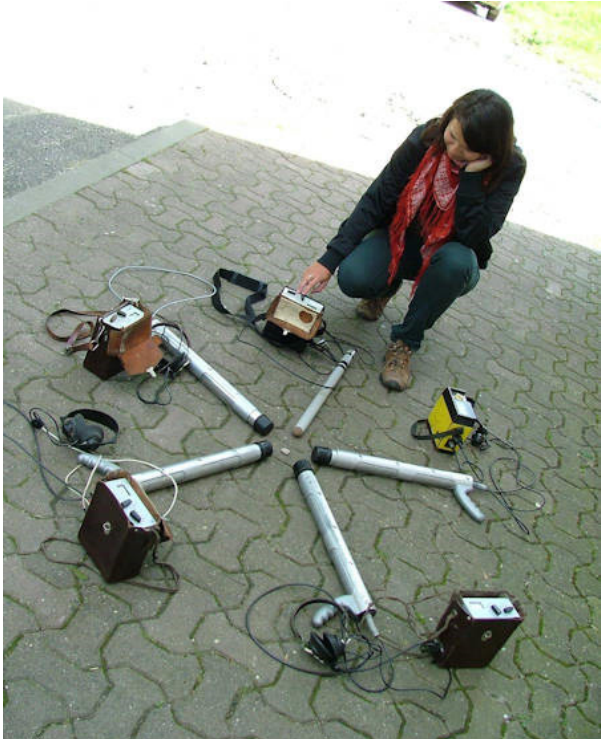
Figure 1. Comparative measurement of RP scintillometers at the field base in Lázn ě Libverda, Claim #3. Photo by Zde ň ka Petrová September 2010, with permission. Claim #3. Photo by Zdeˇnka Petrov á September 2010, with